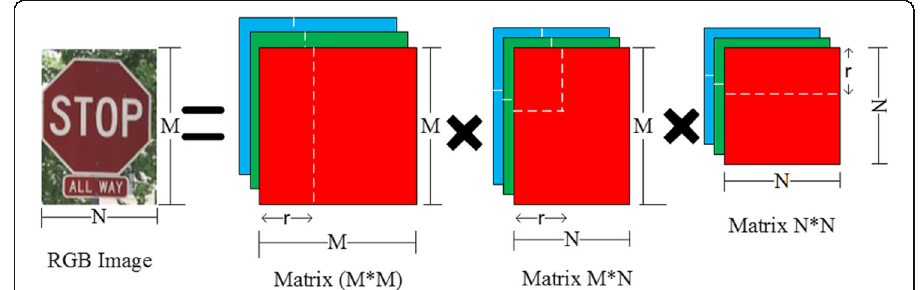
Fig. 5 Singular value decomposition of pixel matrix (the “ r ” in the figure represents the retained singular values and corresponding eigenvectors)